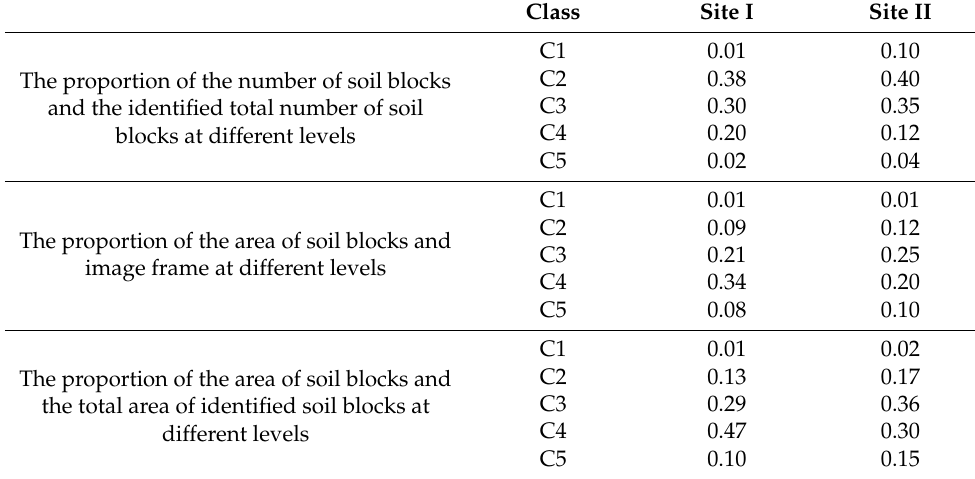
Table 5. The distribution of soil blocks after removing the edge incomplete soil